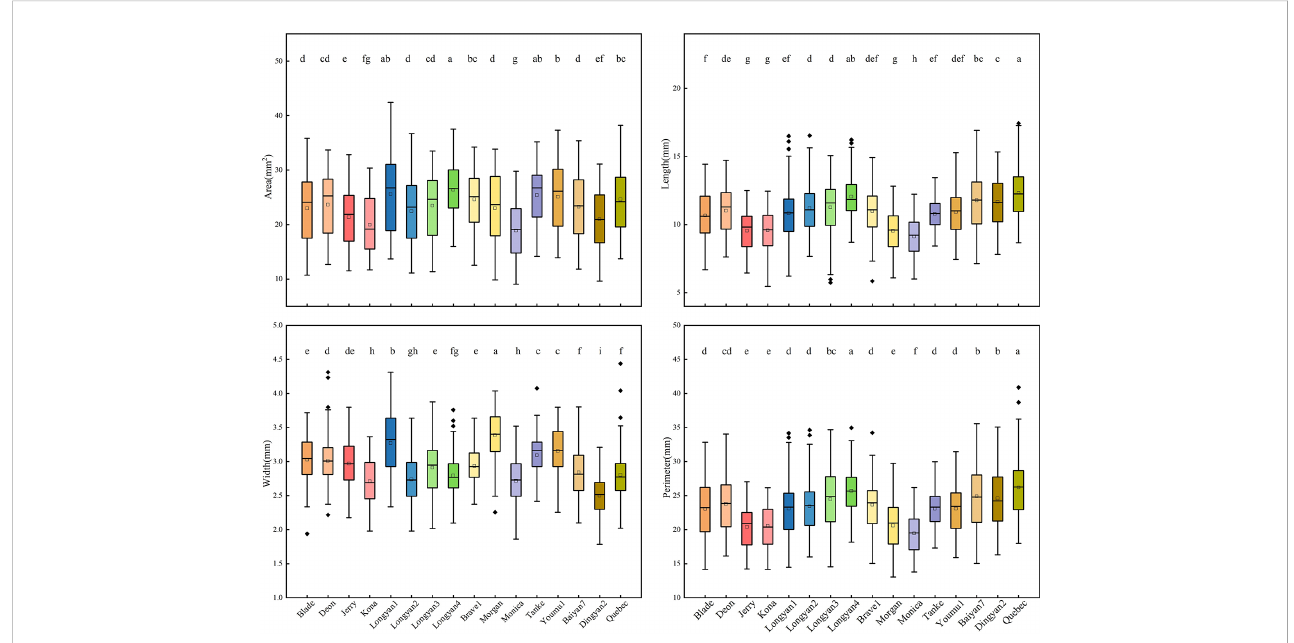
FIGURE 2 Binary features of 16 Avena sativa L. cultivars. Different lowercase letters represent signi fi cant differences between cultivars with the same feature